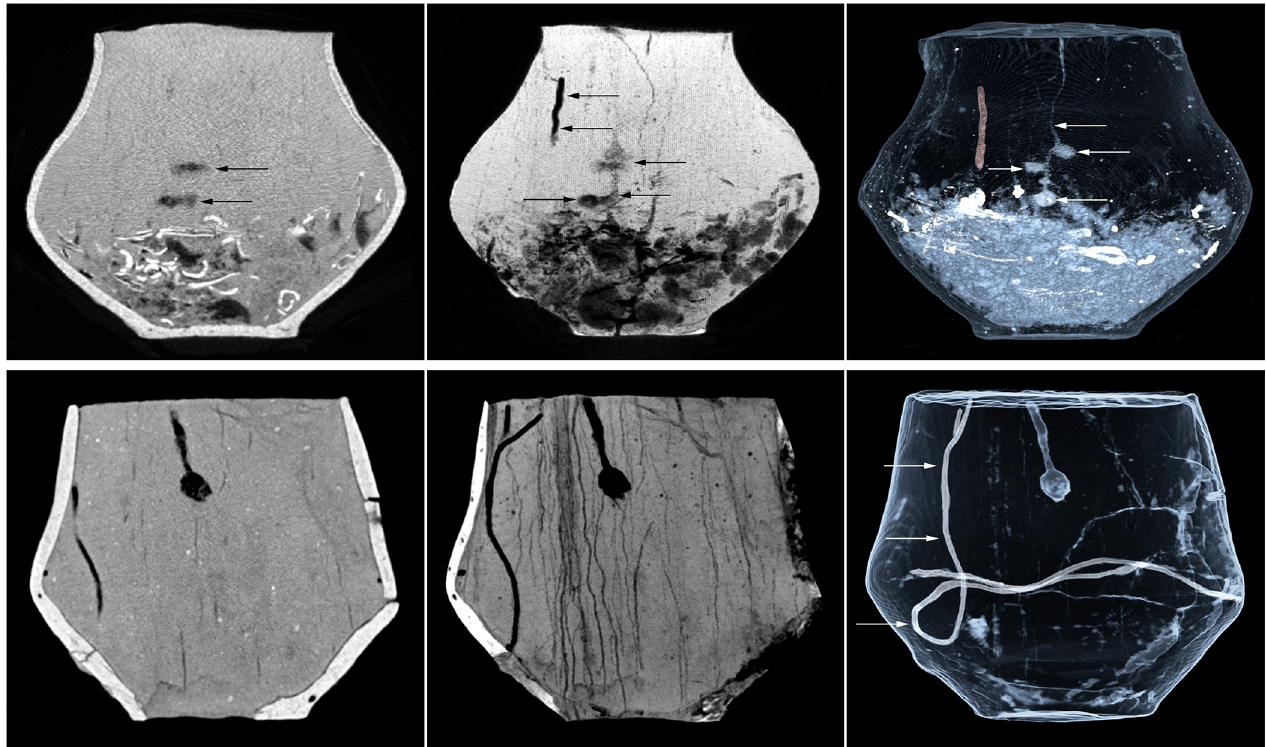
Fig 14. The CT imaging of the fill of the urn from grave 485 and the fill of the additional vessel from grave 600. At the top, the visualization of the urn fill from grave 485 with a preserved corridor of an insect of the genus Harpalus sp. and a disappearing nest of a beetle of the genus Geotrupes sp. At the bottom, the imaging of the interior of the additional vessel from grave 600 with an earthworm tunnel and an aestivation chamber of a different species of earthworm marked with arrows.